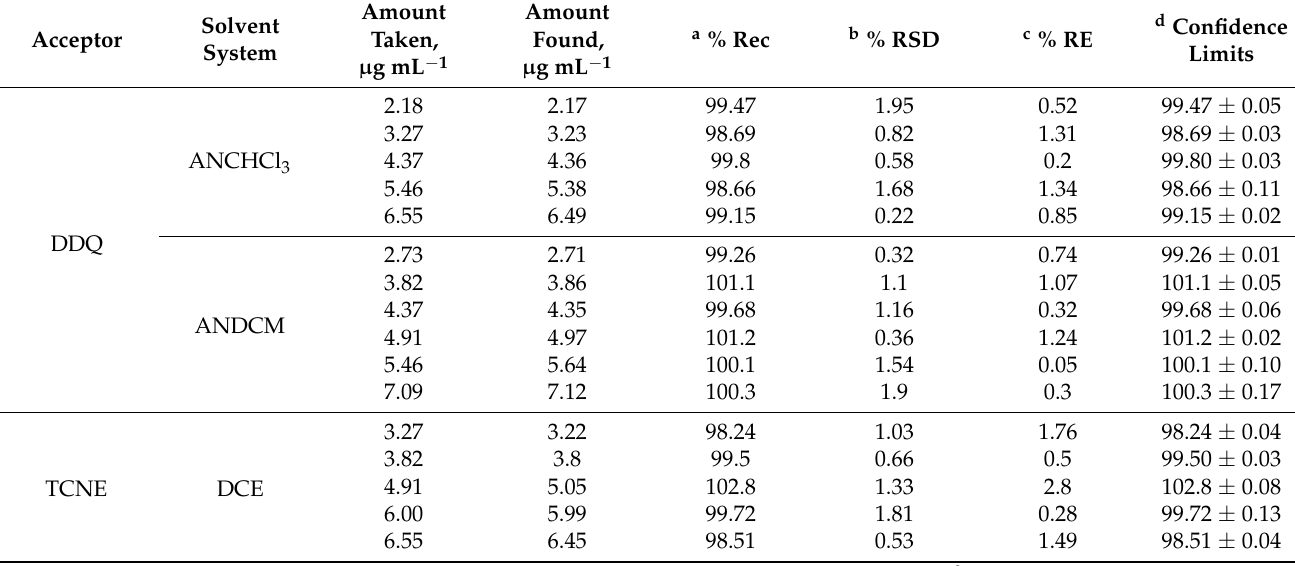
Table 6. Accuracy and precision for the AMFP determination